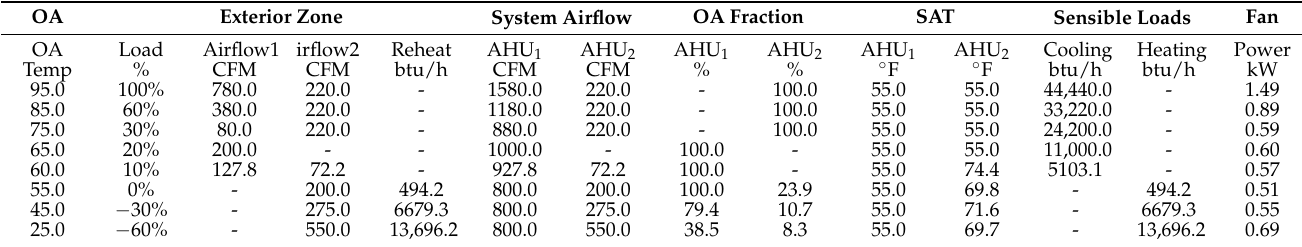
Table 4. Calculations for Dual VAV system with DOA provision and simple SAT reset strategy.